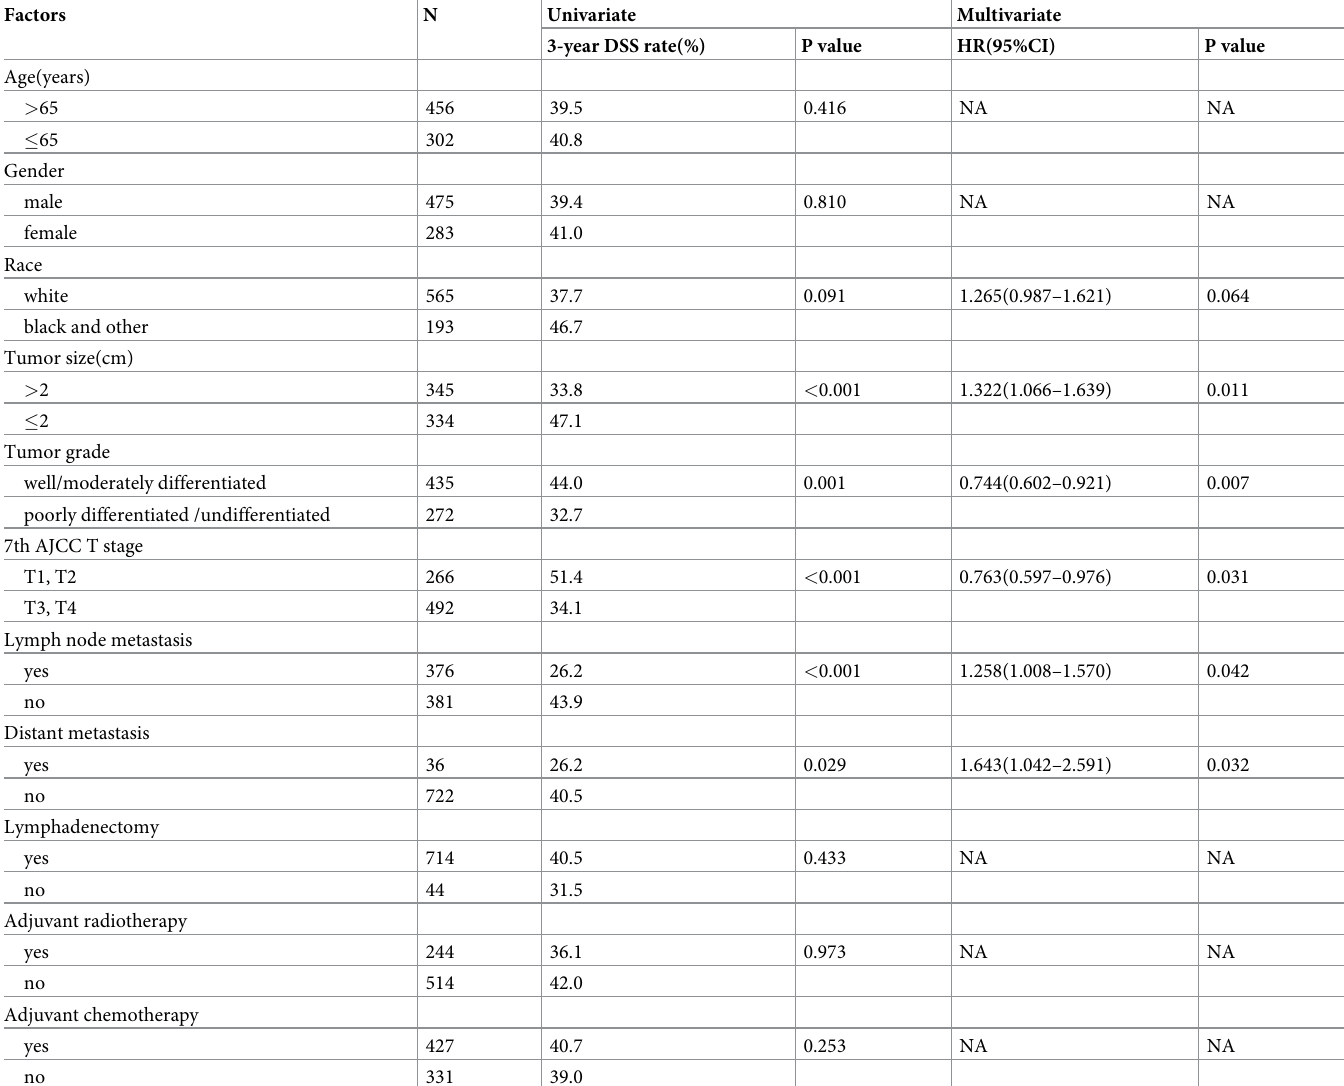
Table 2. Univariate and multivariate analysis of prognostic factors for 758 DCC